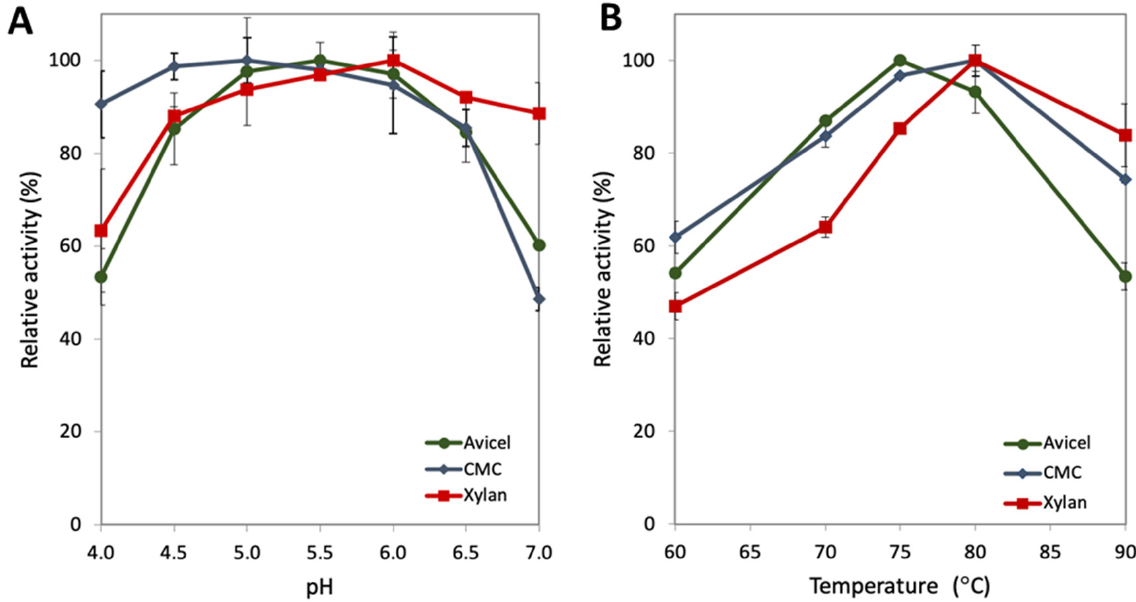
Figure 1. ( A ) Analysis of relative activity of GuxA on Avicel (green), CMC (blue) and xylan (red) at various pH conditions. ( B ) Analysis of relative activity GuxA on Avicel (green), CMC (blue) and xylan (red) at various temperatures.